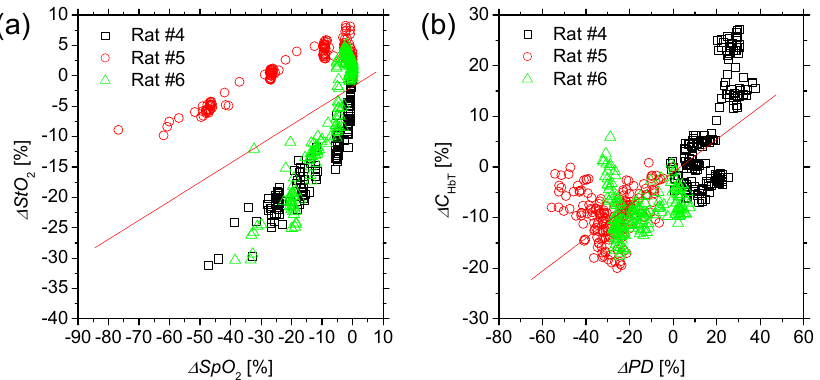
Figure 10. Scatter plots of ( a ) Δ SpO 2 vs. Δ StO 2 and ( b ) Δ C HbT vs. Δ PD obtained from three rats.